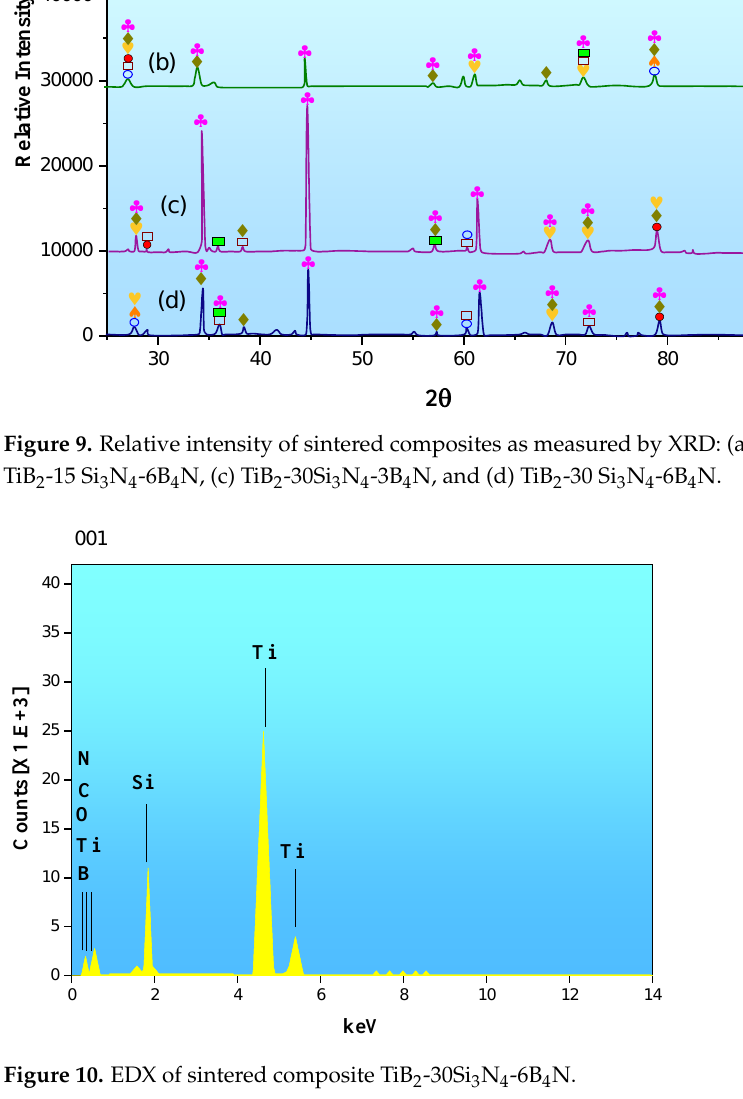
Figure 10. EDX of sintered composite TiB 2 -30Si 3 N 4 -6B 4 N.